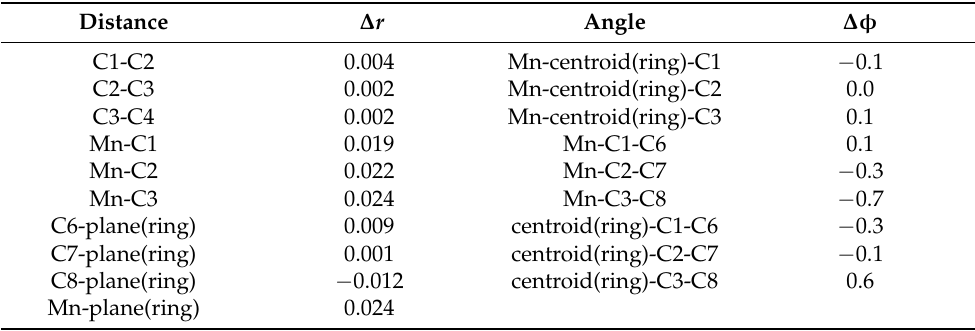
Table 2. Calculated changes in selected bond lengths and atom-plane(ring) distances ∆ r (Å) as well as angles ∆ φ ( ° ) upon ionization of Cp* 2 Mn 0 .